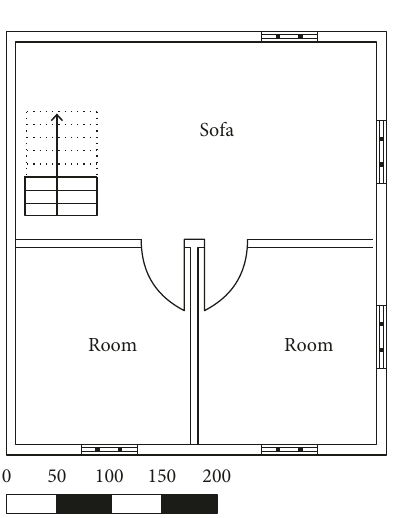
Figure 4: The upper floor